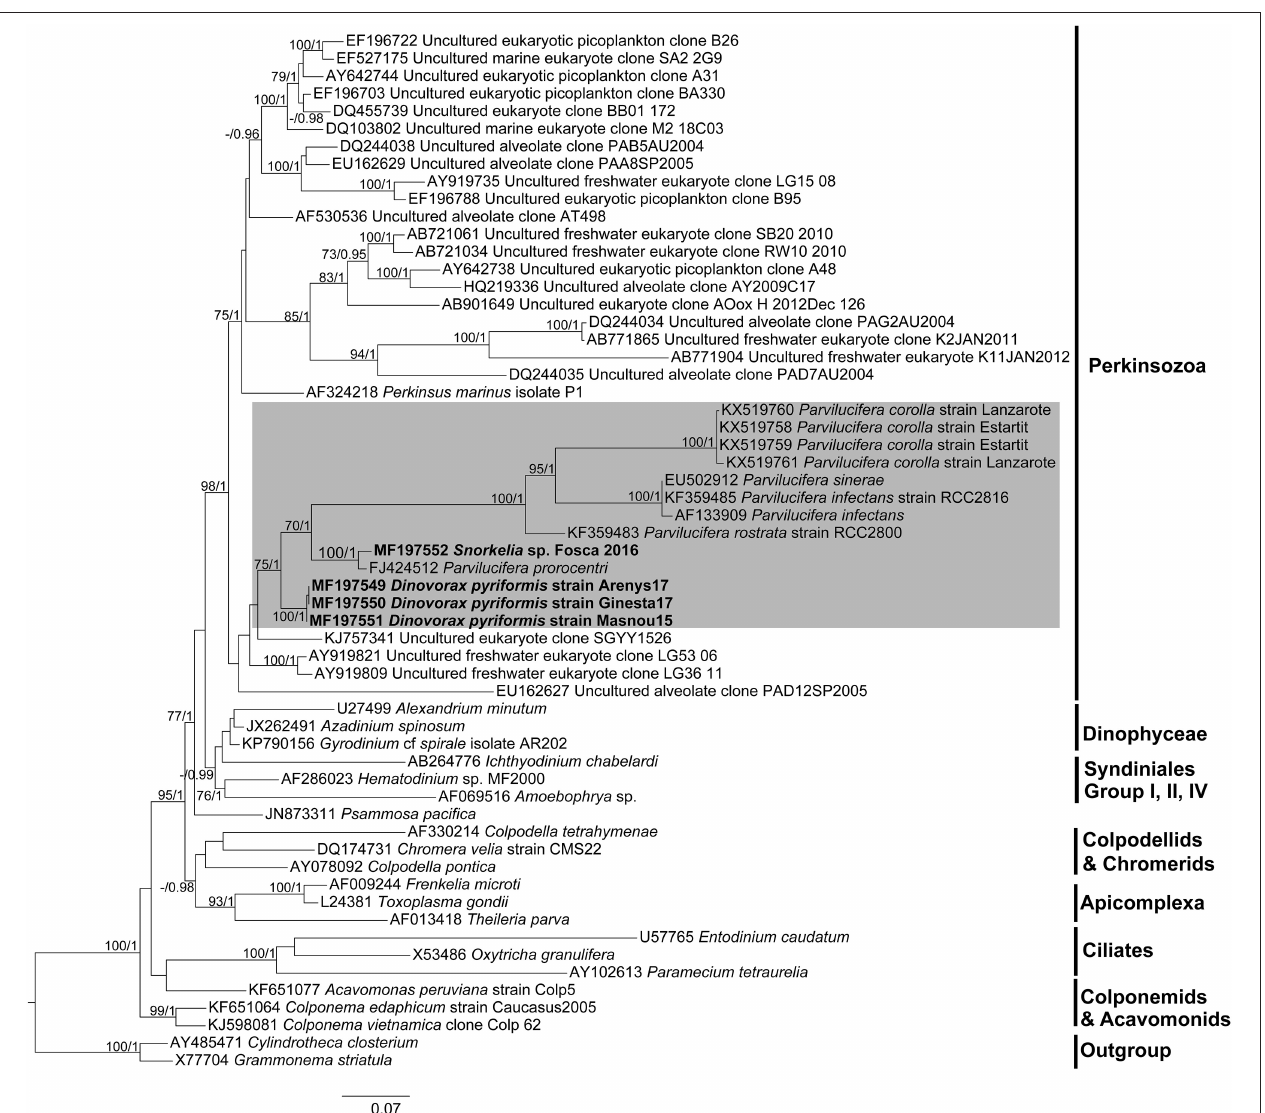
FIGURE 7 | Maximum likelihood phylogenetic tree inferred from the SSU rDNA sequences. Sequences of the diatoms Grammonema striatula and Cylindrotheca closterium served as outgroups. Sequences obtained in this study are indicated in bold and the shaded area encompasses Parviluciferaceae members. The bootstrap values (BS) and Bayesian posterior probabilities (BPP) are provided at each node (BS/BPP). Only BS and BPP values > 70% and > 0.95, respectively, are shown.